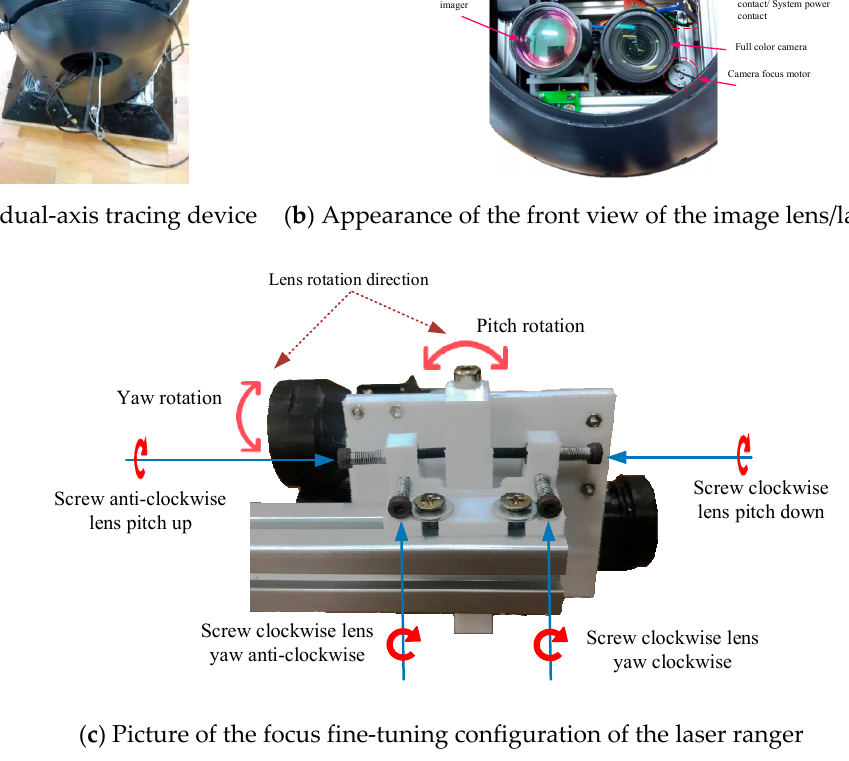
Figure 11. The inner hardware structure of the dual-axis tracing device.